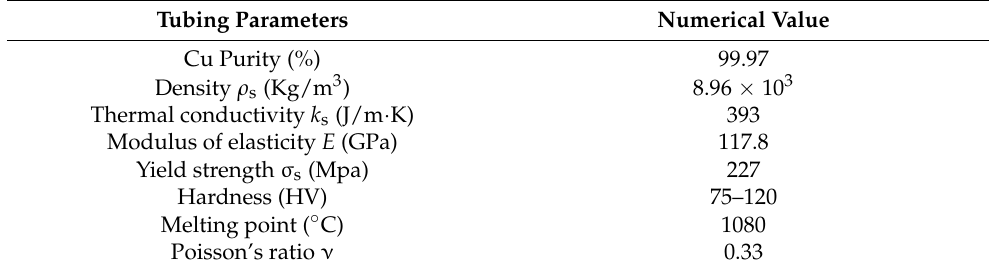
Table 2. TP1 optical pipe properties